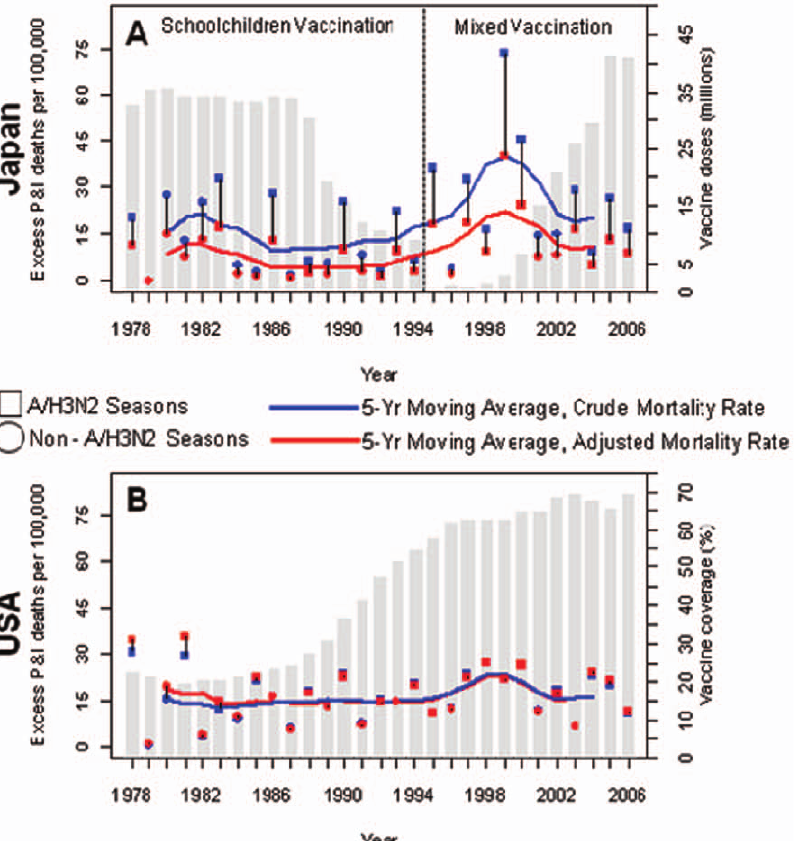
Figure 2. Seasonal excess pneumonia and influenza (P&I) mortality rates among the Japanese (A) and the US elderly (B), aged 65– 89 years, 1977–78 to 2005–06 seasons. Squares represent seasons dominated by influenza A/H3N2 viruses; circles represent seasons dominated by influenza A/H1N1 or B. Blue symbols represent crude excess mortality estimates; red symbols represent excess mortality estimates adjusted for population aging and trends in baseline mortality risk. The blue and red lines represent 5-yr moving averages of the crude and adjusted seasonal excess mortality rates, respectively. Grey bars in (A) represent the number of vaccine doses distributed per influenza season in Japan; grey bars in (B) represent the influenza vaccine coverage among the US non-institutionalized elderly aged $ 65.